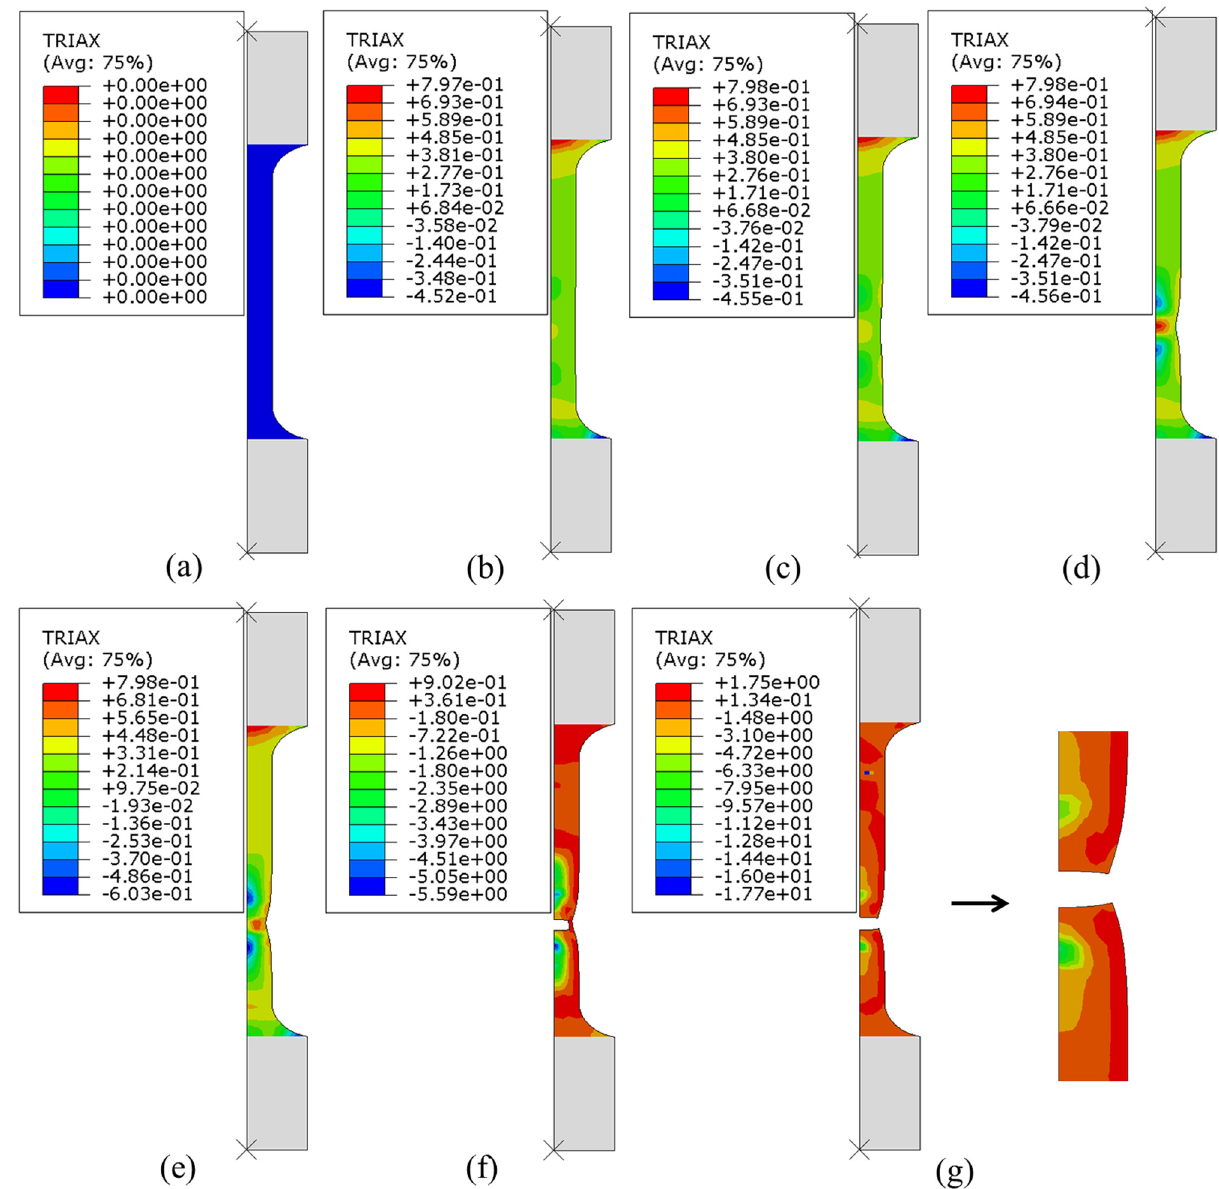
Figure 12: The distribution of stress triaxiality at the true strain of ( a ) 0 s − 1 , ( b ) 0.05 s − 1 , ( c ) 0.1 s − 1 , ( d ) 0.15 s − 1 , ( e ) 0.2 s − 1 , ( f ) 0.229 s − 1 , and ( g ) 0.23 s − 1